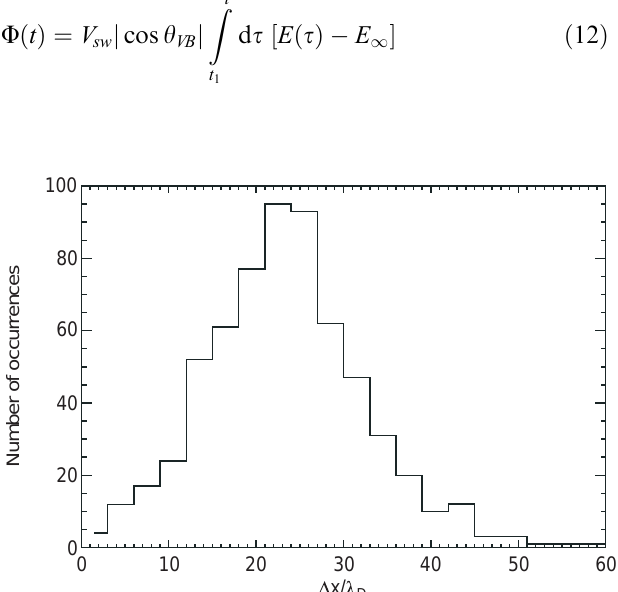
Fig. 5. Histogram of the spatial width of the 626 IES which belong to region III in Fig.